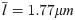
Comparison between theory and the simulations.The order parameter S1 as a function of the average membrane density of polarity factors γ as determined in 2D particle-based simulations with p = 5 and R = 3μm. The parameter η was tuned by changing the spontaneous catastrophe rate of the microtubules, yielding microtubules of mean length l¯=1.77μm (top curve) and l¯=2.54μm (middle and bottom curves).The corresponding theoretical predictions for the polarized regimes are shown as gray bars above each curve. Error bars denote standard errors in the mean from multiple independent runs.